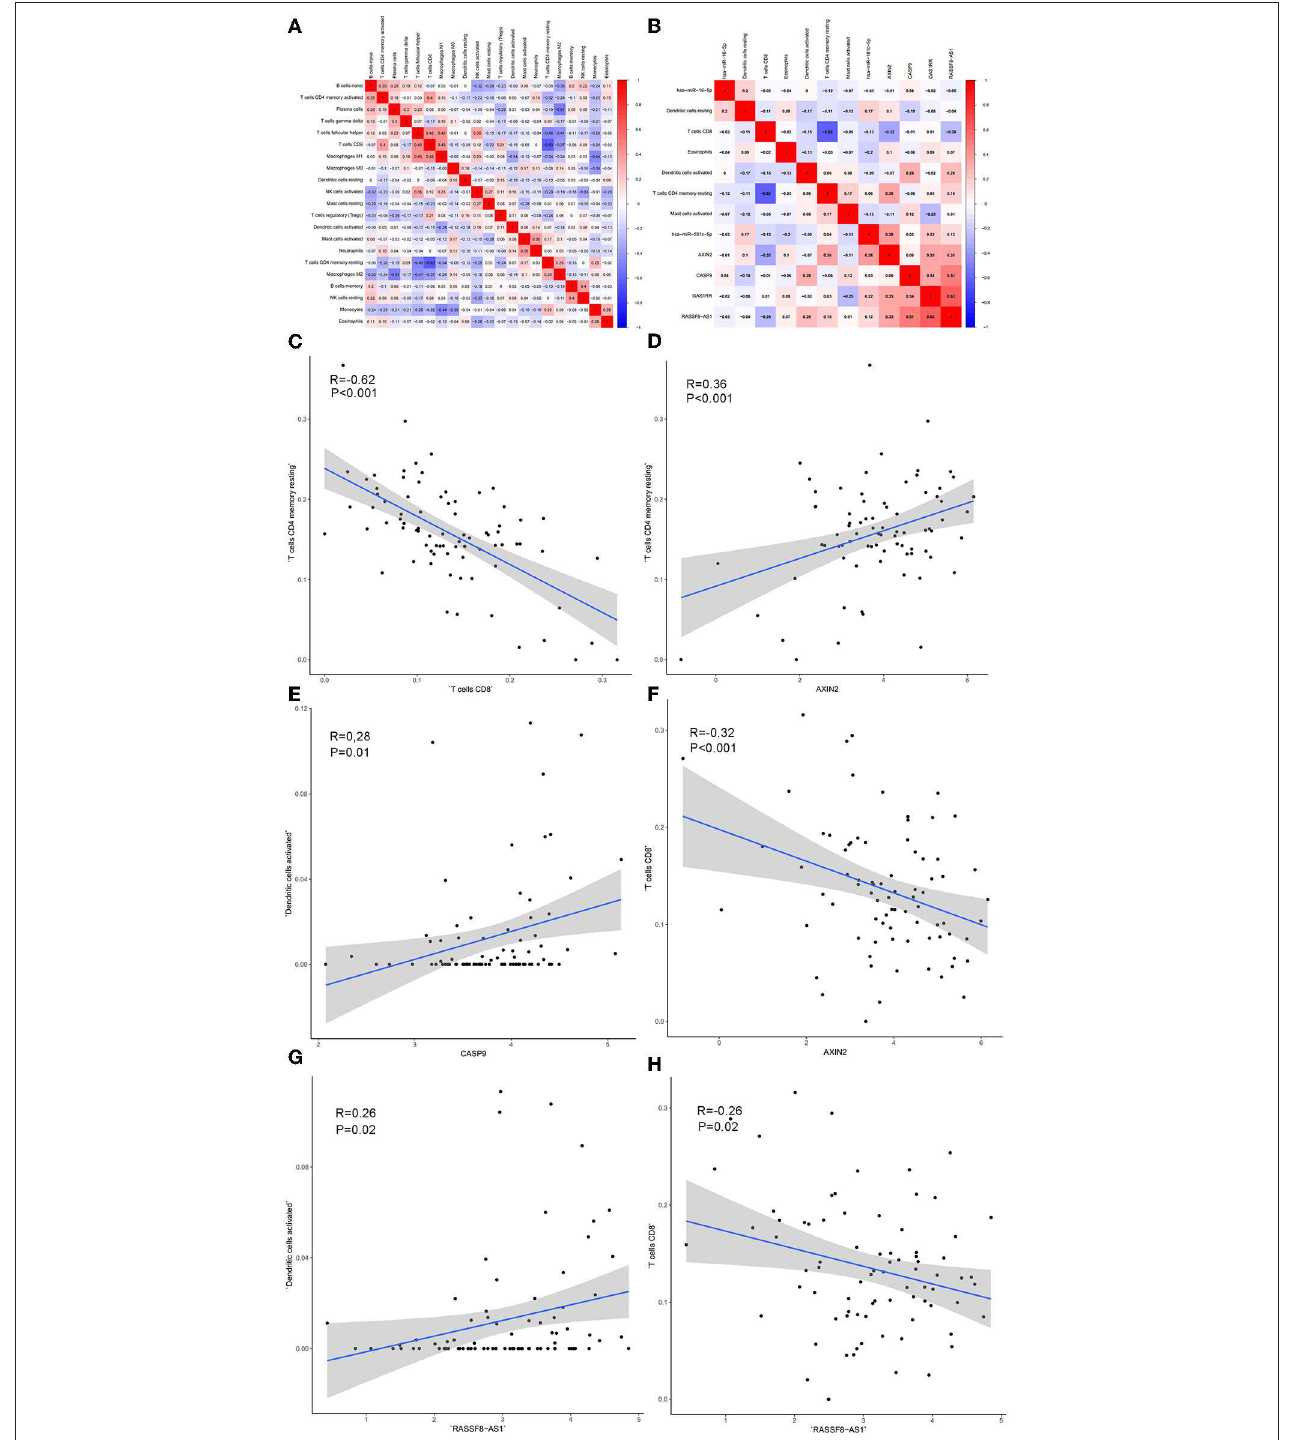
FIGURE 8 | The co-expression patterns among fractions of immune cells (A) ; the co-expression patterns among fractions of immune cells and key members in the ceRNA network (B) ; the relationships among immune cells and between ceRNAs and immune cells were calculated using Pearson correlation coefficients: T cells CD4 memory resting and T cells CD4 (C) ; T cell CD4 memory resting and AXIN2 (D) ; Dendritic cells activated and CASP9 (E) ; T cells CD8 and AXIN2 (F) ; Dendritic cells activated and RASSF8-AS1 (G) ; T cells CD8 and RASSF8-AS1 (H) .